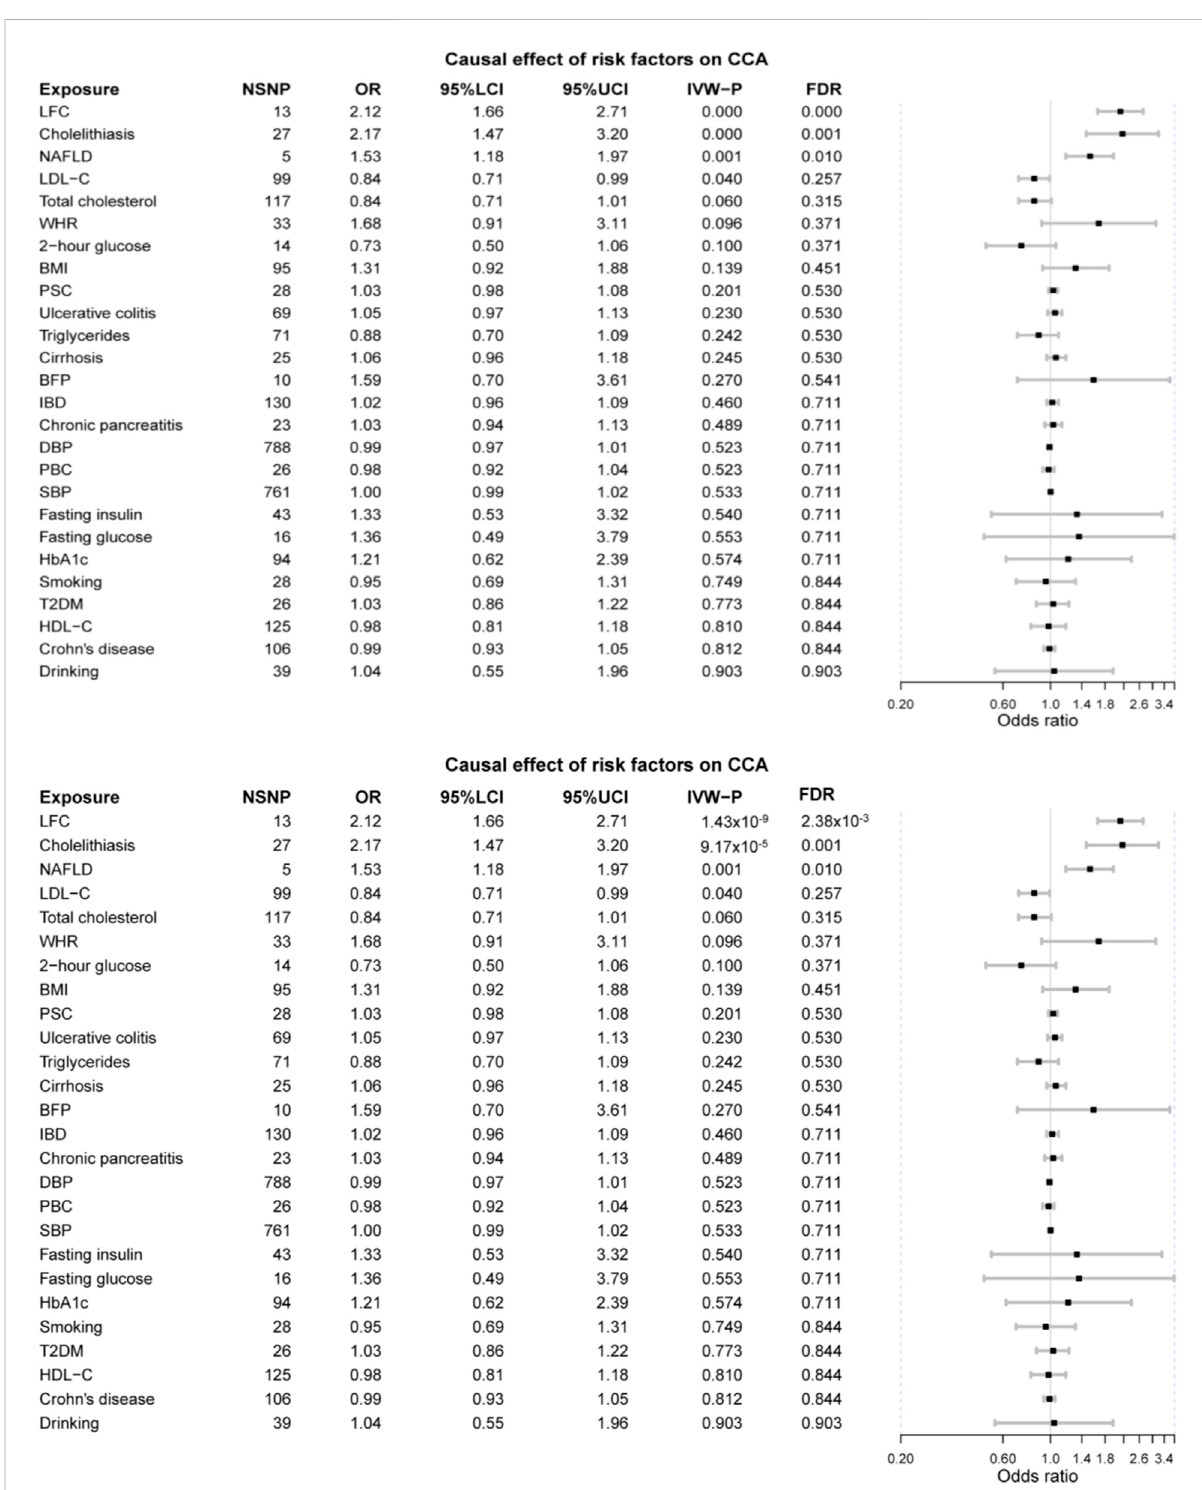
FIGURE 2 The forest plot of MR results. LFC, liver fat content; NAFLD, non-alcoholic fatty liver disease; LDL-C, low-density lipoprotein cholesterol; WHR, waist-to-hip ratio; BMI, body mass index; PSC, primary sclerosing cholangitis; BFP, body fat percentage; IBD, in fl ammatory bowel disease; DBP, diastolicbloodpressure;PBC,primarybiliarycholangitis;SBP,systolicbloodpressure;HbA1c,glycated hemoglobin;T2DM,type2diabetes mellitus; HDL-C, high-density lipoprotein